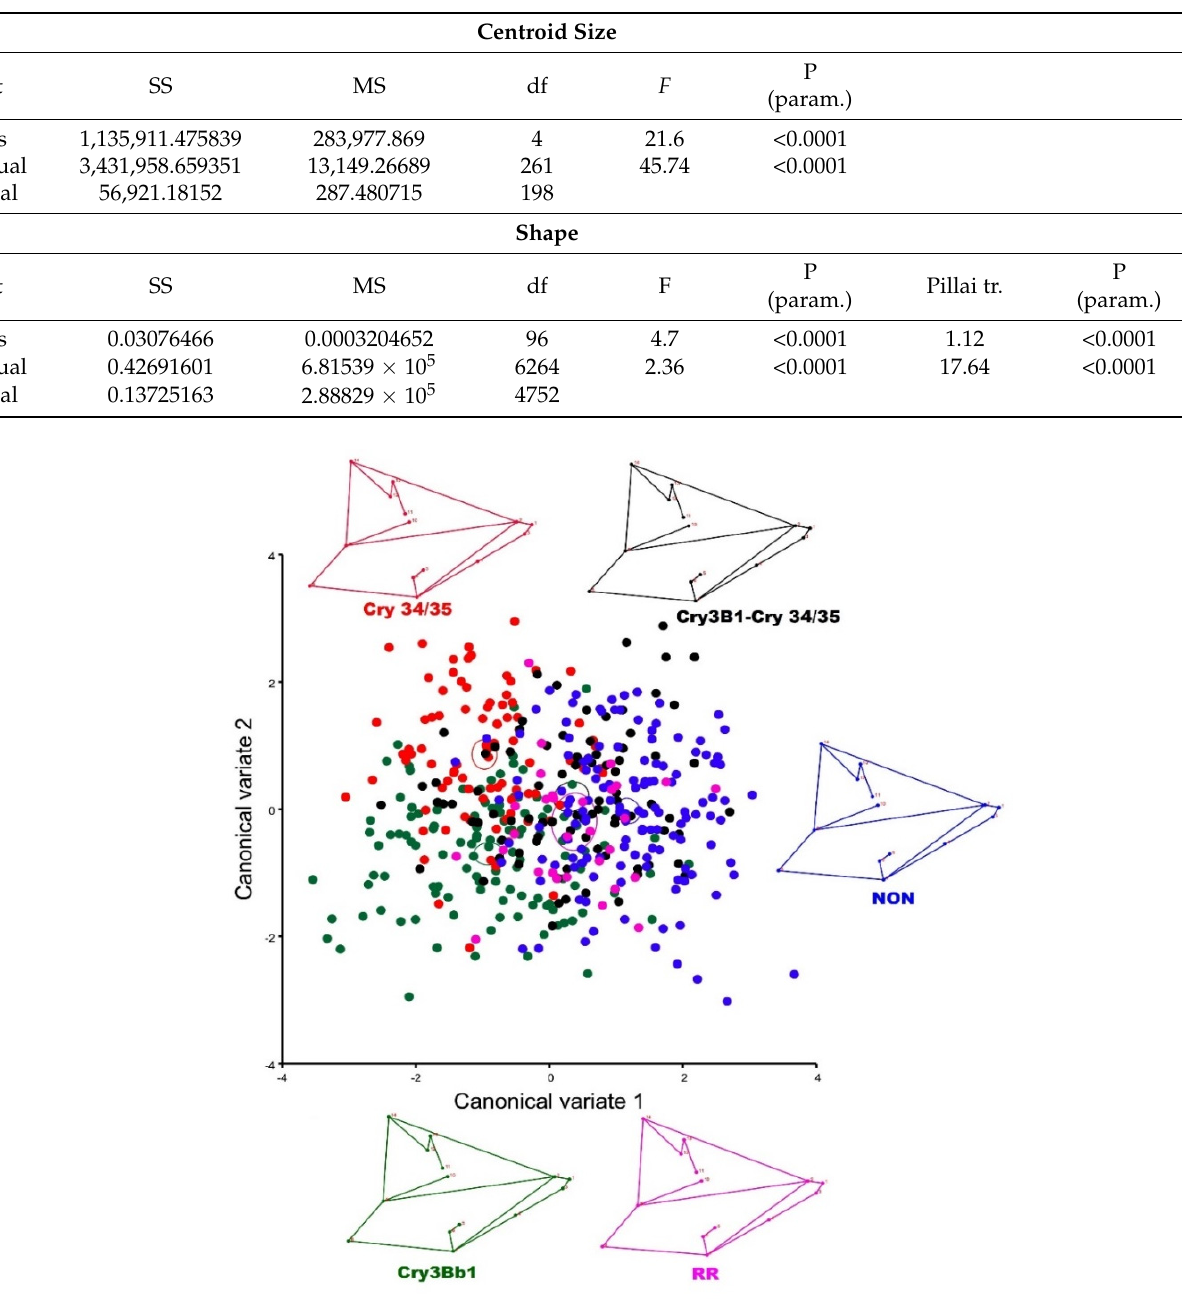
Figure 8. Canonical variate analysis of the hindwing shape between different populations resistant to the toxins: adapted to crop rotation and non-resistant population in Diabrotica virgifera virgifera . Color and sign code: red Cry34/35Ab1 resistant population; green CryBb1 resistant population; pink population adapted to crop rotation (RR); black CryBb1-Cry34/35Ab1 resistant population; and blue (NON): non-resistant population. Table 5. Mahalanobis and Procrustes distances between groups obtained from canonical variate analysis. *: p < 0.05; **: p < 0.001.